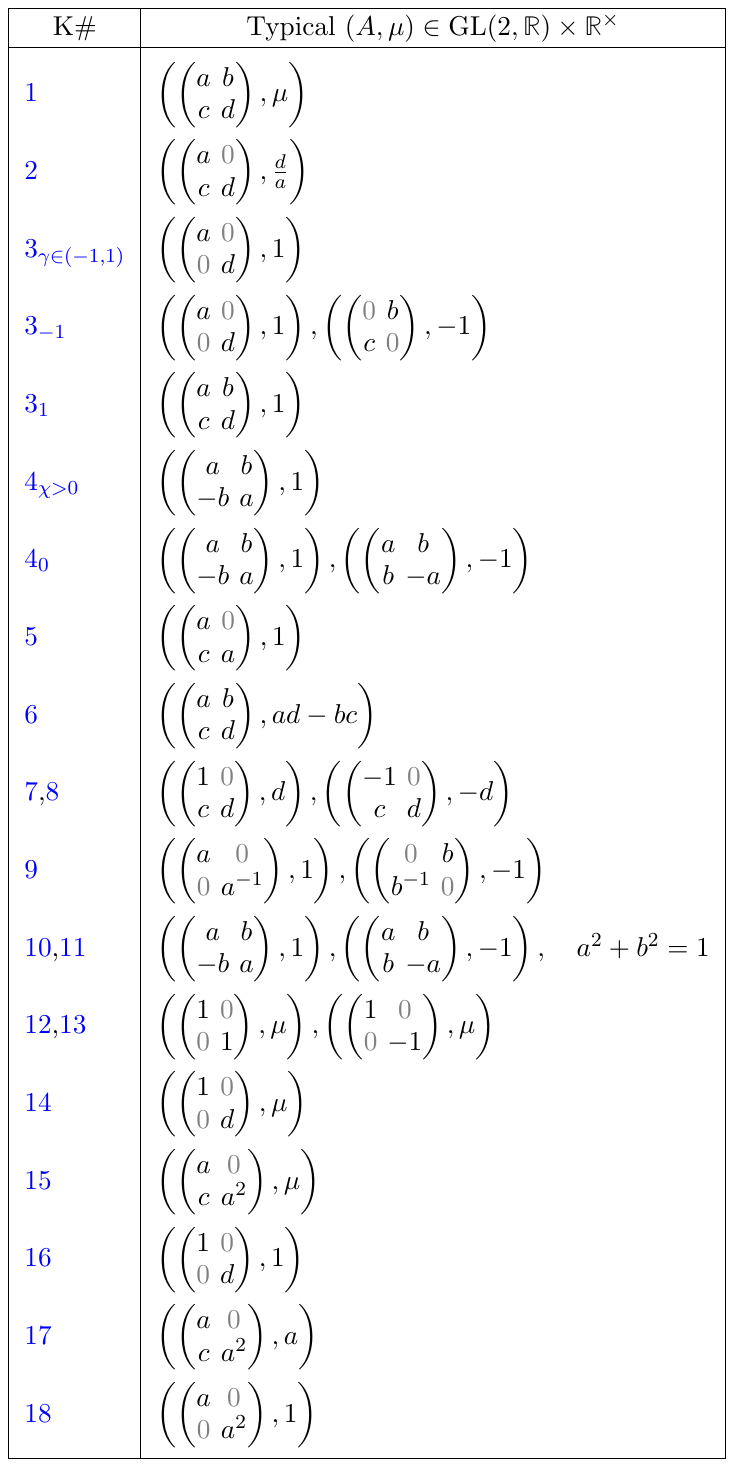
Table 3 . Automorphisms of kinematical Lie algebras (acting trivially on r